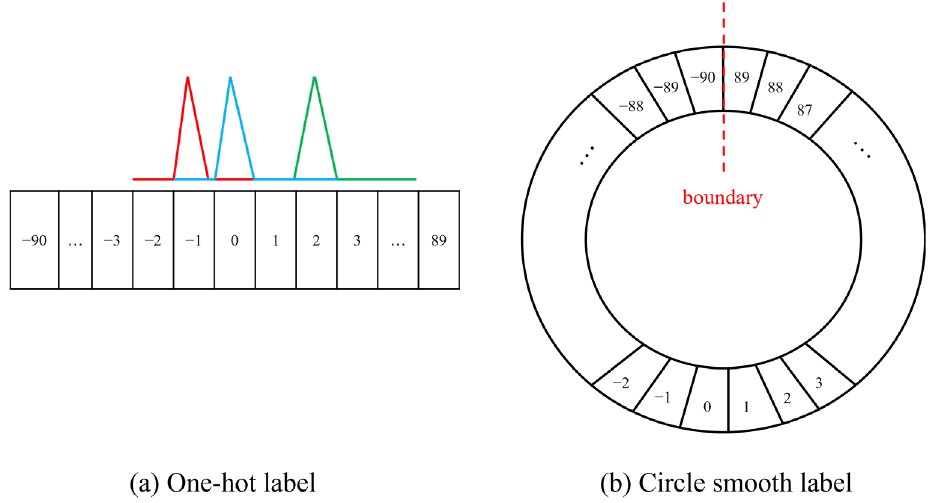
Figure 7. The picture on the left is the mapping relationship for one-hot encoding of angles. The picture on the right is a closed loop formed by angles. There are boundaries between angles − 90 and 89, and the loss function suddenly increases during this process.